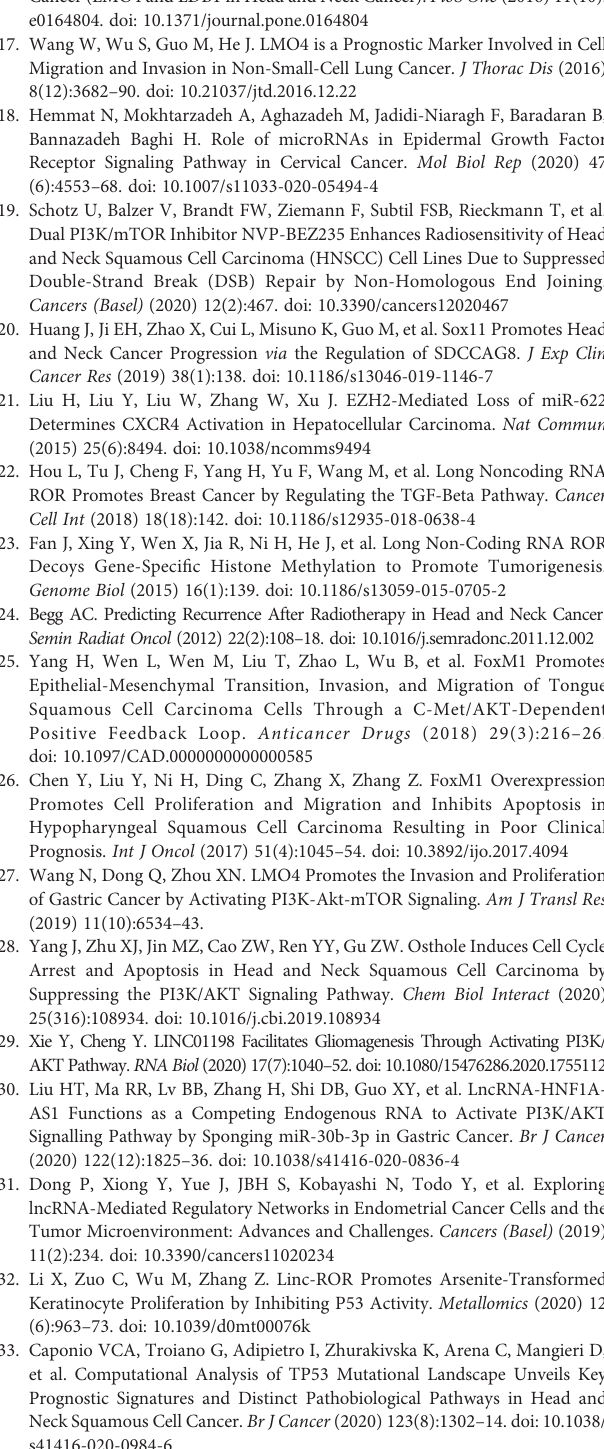
Supplementary Figure 2 | Silencing ef fi ciency of sh-Linc-ROR-1, sh-Linc-ROR- 2, sh-LMO4-1 and sh-LMO4-2 determined by RT-qPCR. * p < 0.05, compared with the sh-NC